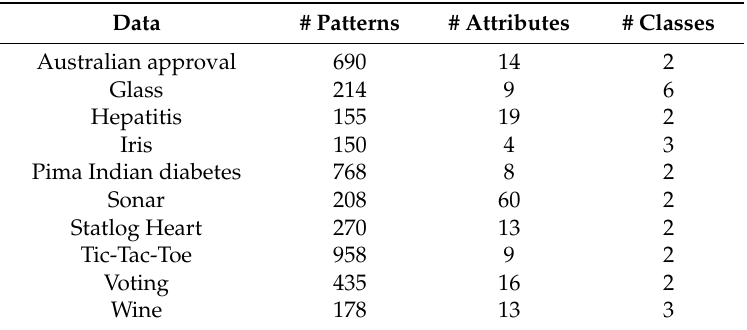
Table 2. Data used in computer